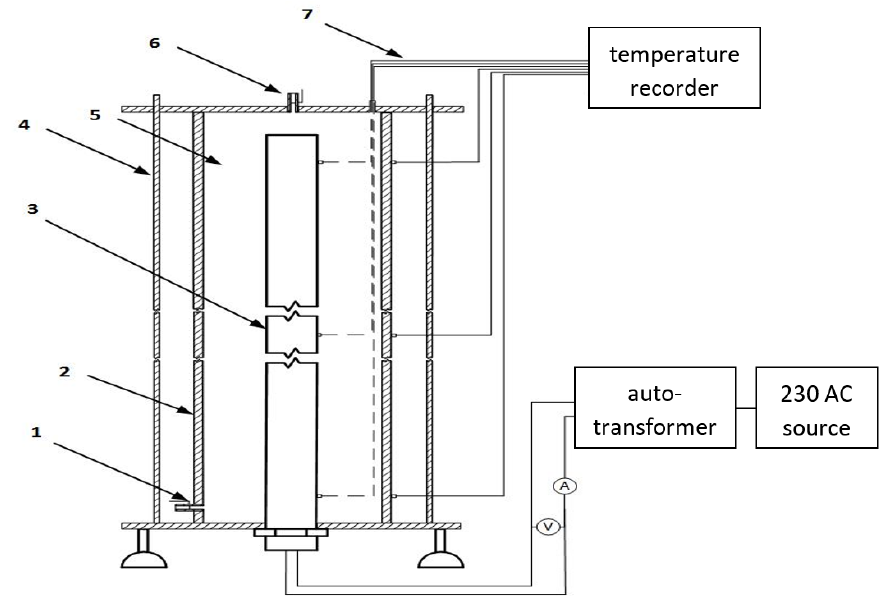
Figure 2. Diagram of the designed system for determining the heat transfer coefficient α; 1— valve, 2 — tank (steel pipe), 3 — heating element (heater), 4 — pin fixing the top and bottom cover of the tank, 5 — electro-insulating liquid, 6 — valve, 7 — measuring probes.